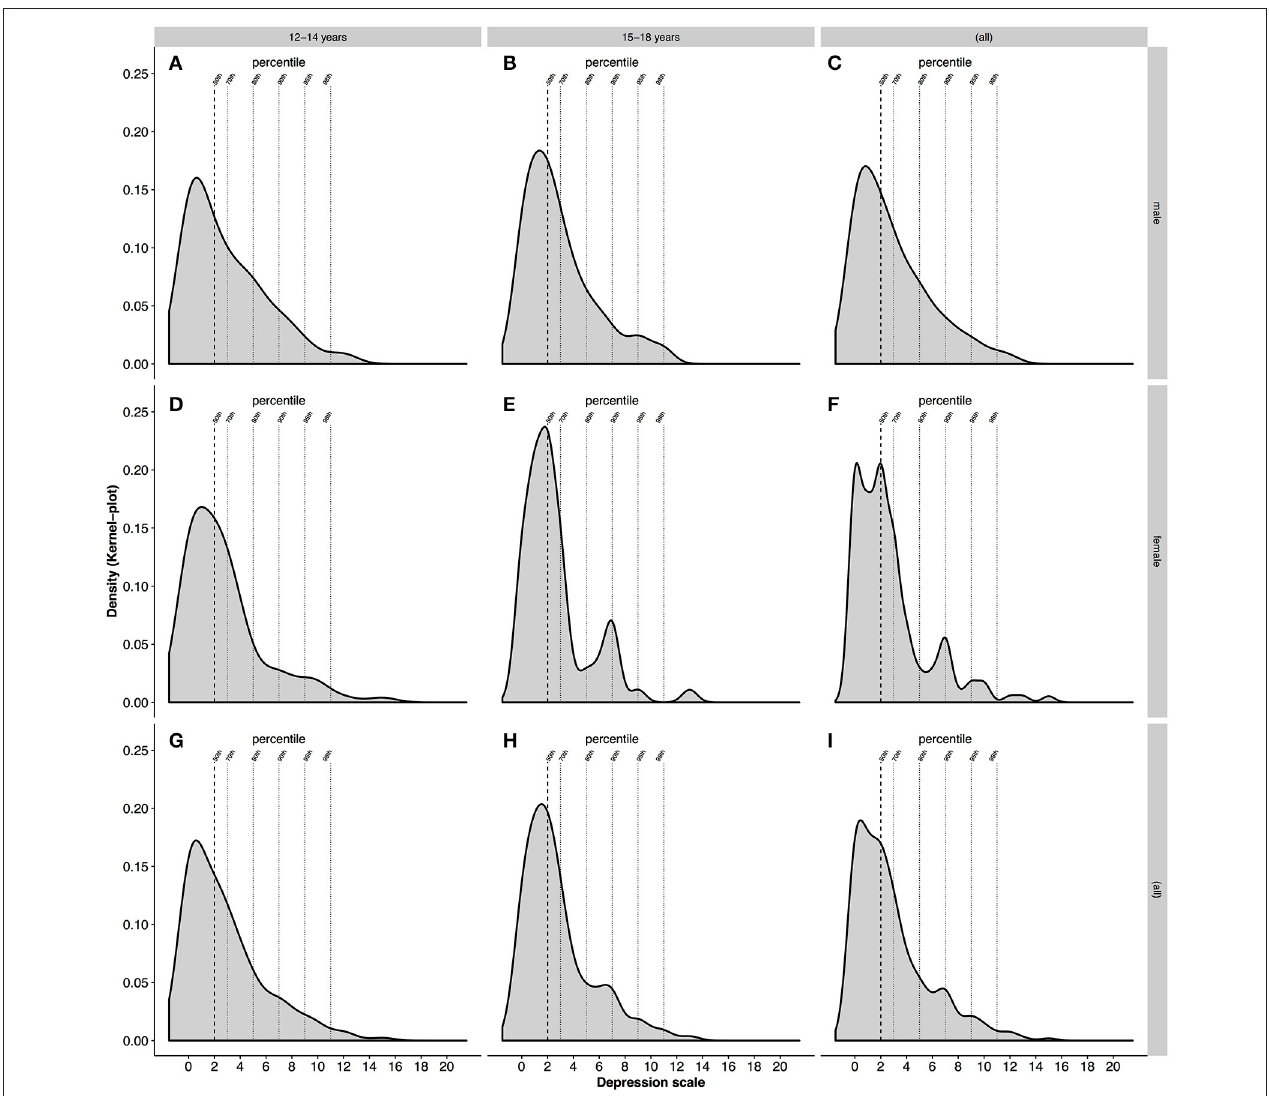
FIGURE 5 | Density of the distribution of depression. (A–C) Shows male athletes in late childhood, late adolescents and overall, respectively. (D–F) Shows female athletes in late childhood, late adolescents and overall, respectively. (G , H) Shows late childhood and late adolescents regardless of gender. (I) Shows the density of depression for all